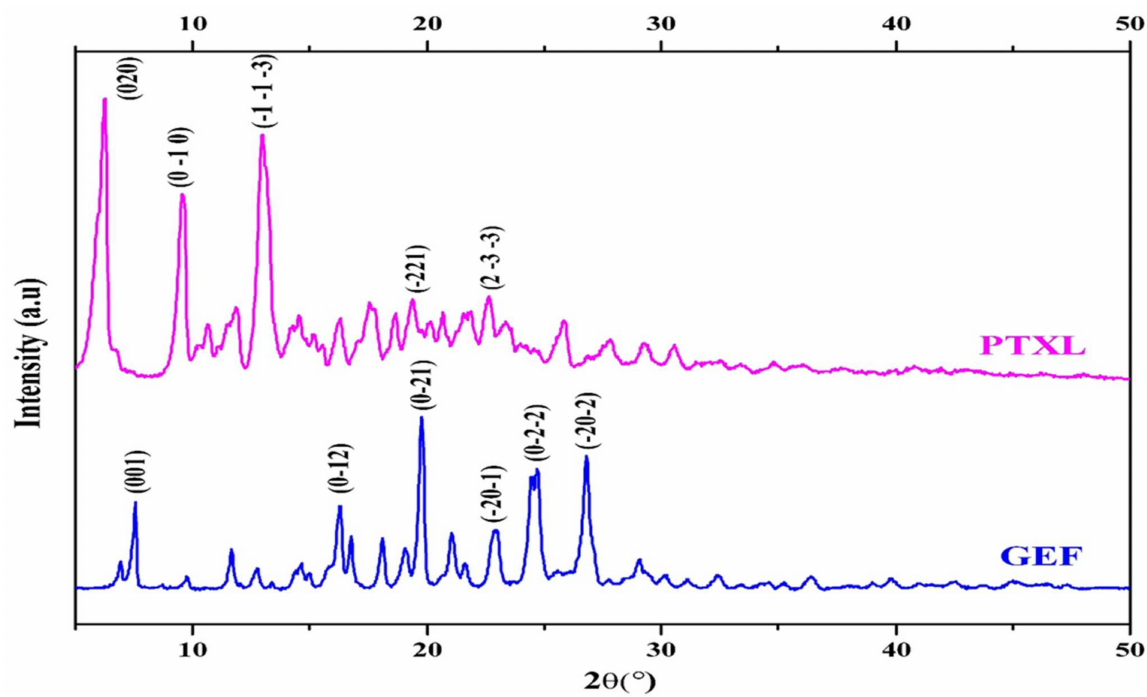
Figure A2. Powder X-ray diffractograms (XRD) pattern of GEF and PTXL with the miller indices (h, k, l) planes.